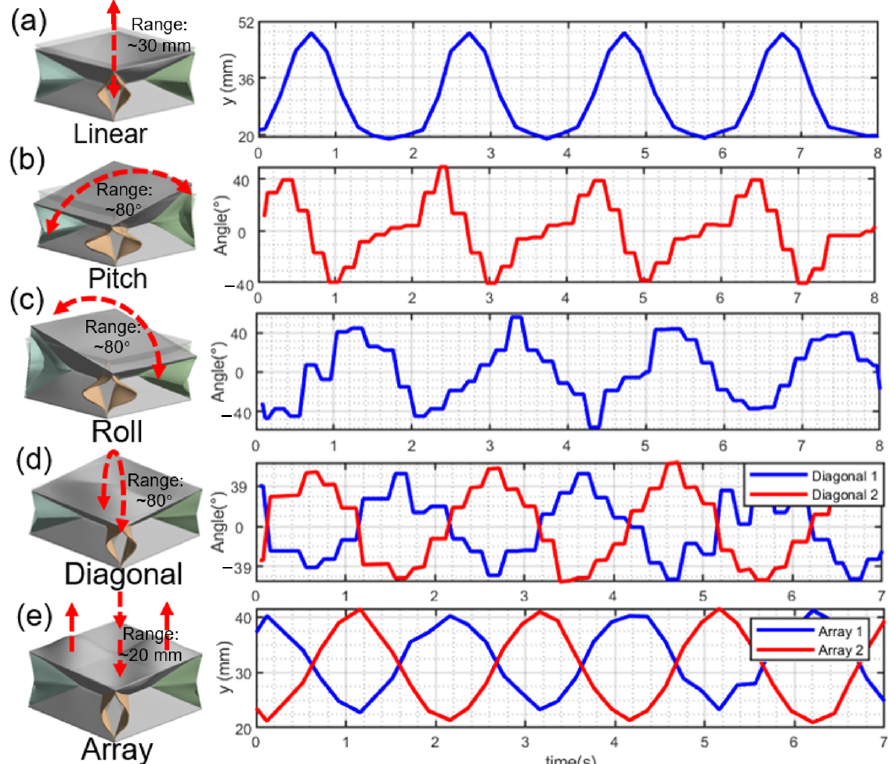
Figure 6. The five motion modes (linear, pitch, roll, diagonal, and array motion) of our origami structure are demonstrated from ( a – e ) based on the simulation results in ANSYS Workbench. Here, one vertex of origami structure is selected as the tracking objective, which indicates that the maximum displacement along the Z direction is around 30 mm, and the maximum pitch or roll angle is around 40 ◦